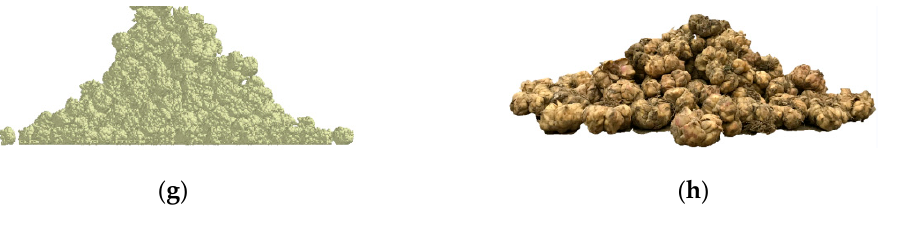
Figure 11. The picture of stacking Lily bulb. ( a ) Parameter group a; ( b ) Parameter group b; ( c ) Parameter group c; ( d ) Parameter group d; ( e ) Parameter group e; ( f ) Parameter group f; ( g ) Parameter group g; ( h )The lily bulb stacking map of the bench test.